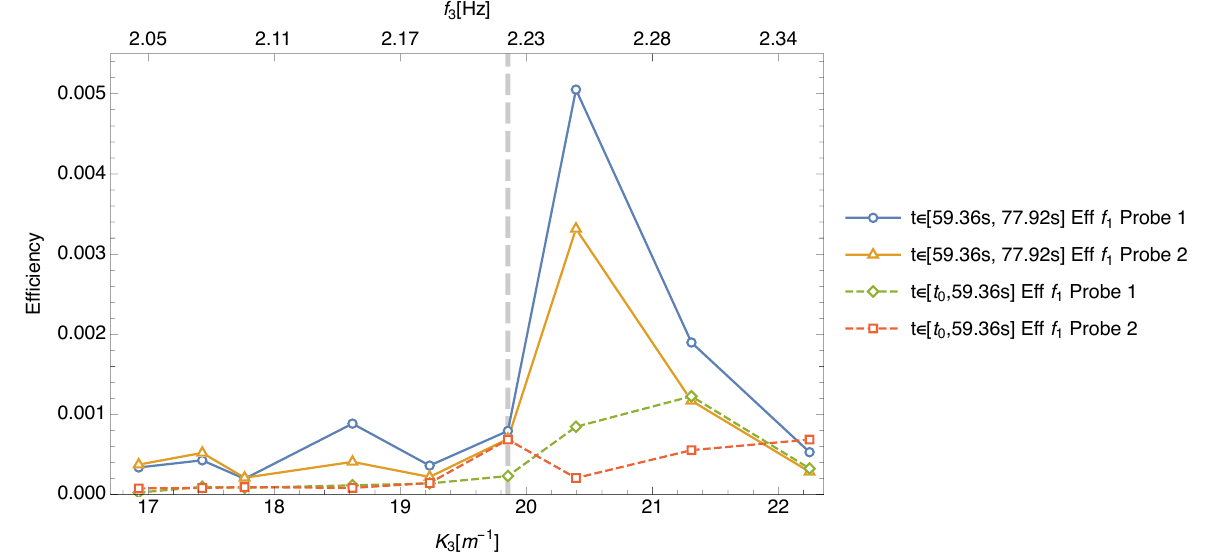
Figure 18. Efficiency as a function of the experiment, for the two probes and for early (dashed lines) and late (solid lines) measurements. An efficiency of 0.005 corresponds to 0.5% efficiency. The initial time for the early measurements is the theoretical time (which depends on the experiment) when the first nonlinearly-produced wavepackets with central wavenumbers ± K 1 arrive at the probes: For the 9 experiments, t 0 = { 14.44,15.04,15.44,16.44,17.14,17.84,18.42,19.42,20.42 } s. The final time for the early measurements is the theoretical time (which is fixed) when the first wavepackets with central wavenumbers ± K 2 arrive at the probes after reflecting from the ends of the tank. The dashed grey vertical line corresponds to the theoretical resonant case K 1 : K 2 : K 3 = 16 : 9 :